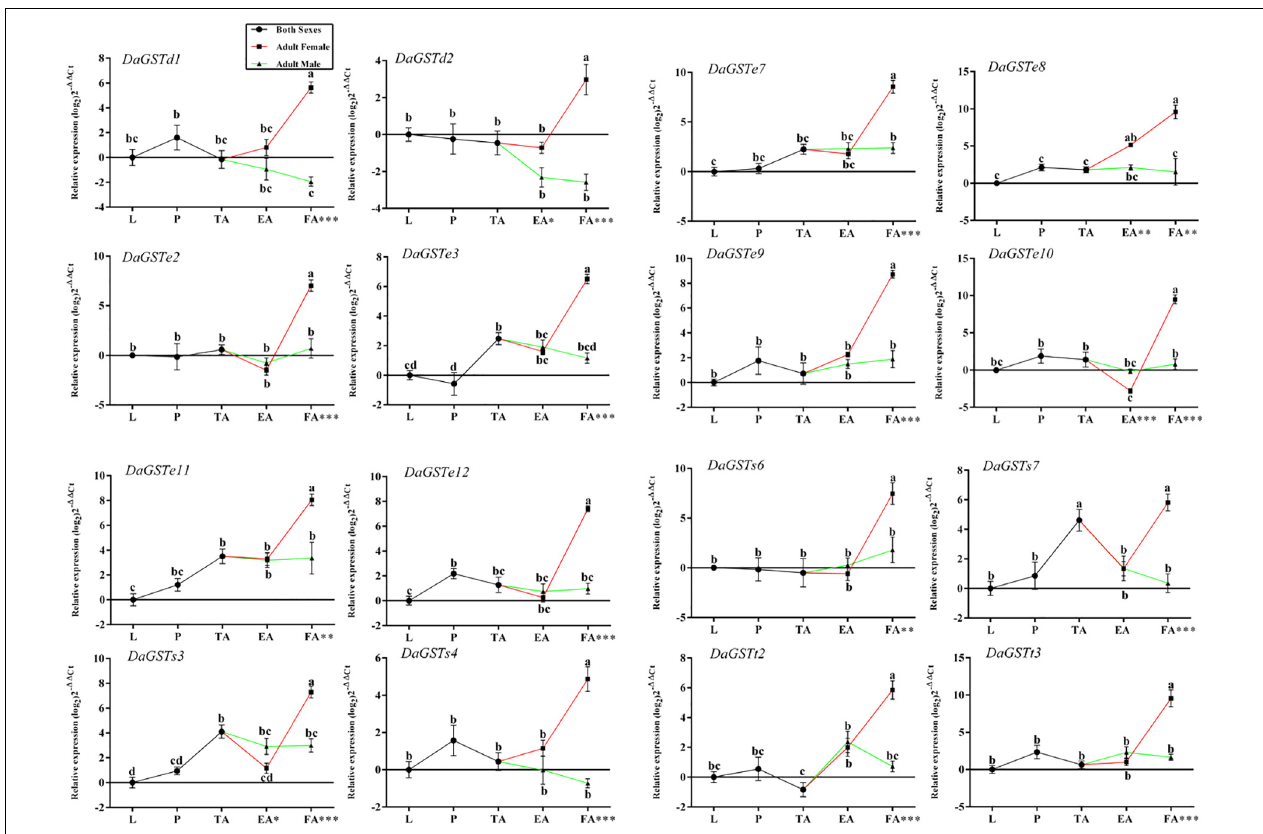
FIGURE 3 | Quantitative expression of GST genes (mean ± SE, n = 3) in different developmental stages of Dendroctonus armandi . L, larvae; P, pupae; TA, teneral adults; EA, emerged adults; FA, feeding adults, females and males of the two latter stages of Dendroctonus armandi . GST expression was normalized to the transcription levels geometric mean of β - actin and CYP4G55 . Different letters indicate significant differences from the different development stages ( P < 0.05) by Duncan’s test. ∗ Significant differences between sexes of the same stage as measured by independent Student’s t -tests ( ∗ P < 0.05, ∗∗ P < 0.01, ∗∗∗ P < 0.001). The 2 − (cid:49)(cid:49) Ct and SE values were log 2 transformed for plotting ( DaGST s expression is upregulated if the − (cid:49)(cid:49) Ct has a positive value, and downregulated for negative values). Statistically significant differences in gene expression are shown in Supplementary Table S2 .